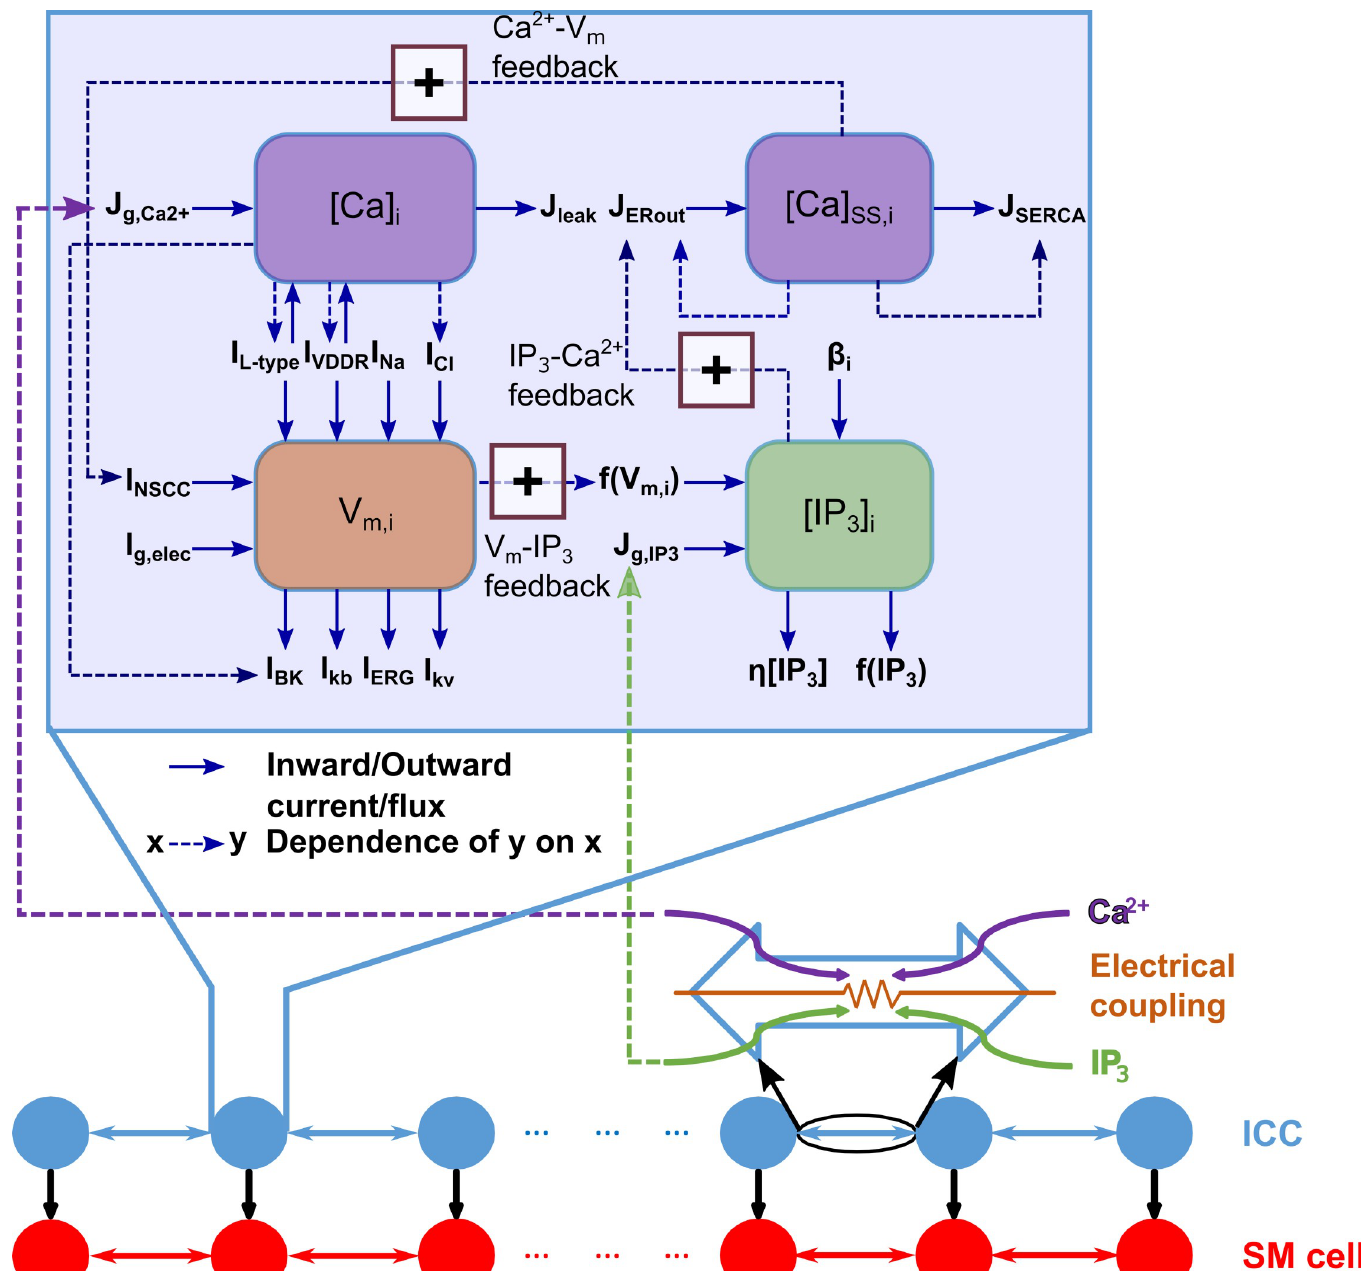
Fig 2. Gastric Motility Network model architecture. The GMN is constituted of a chain of nearest-neighbor coupled interstitial cells of Cajal (ICC) and associated smooth muscle (SM) cells. The ICCs have electrical and second messenger (Ca 2+ and IP 3 ) based coupling, while the ICC to SM and SM to SM couplings are only electrical. There is a negative gradient in enteric neural innervation ( β ) that modulates IP 3 production rate along the rostrocaudal ICC chain (ICC index). Key variables and their interconnections impacting the functionality of an ICC are illustrated in the enlarged inset. The bold arrows in the inset show the inflows and outflows of key variables. The dashed arrows indicate dependency of the sink variable on the source variable. The dashed arrows with (+) sign highlight the positive feedback pathways important for intrinsic pacemaking by an ICC. See Table 1 and text for further